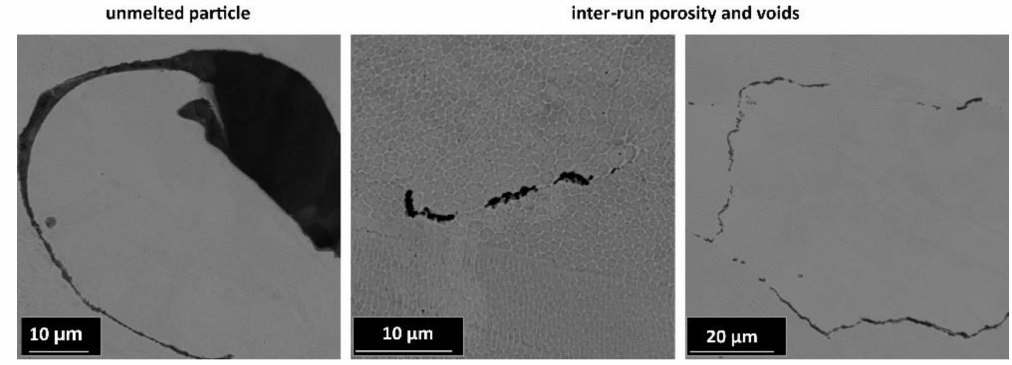
Figure 12. SEM images showing microstructure